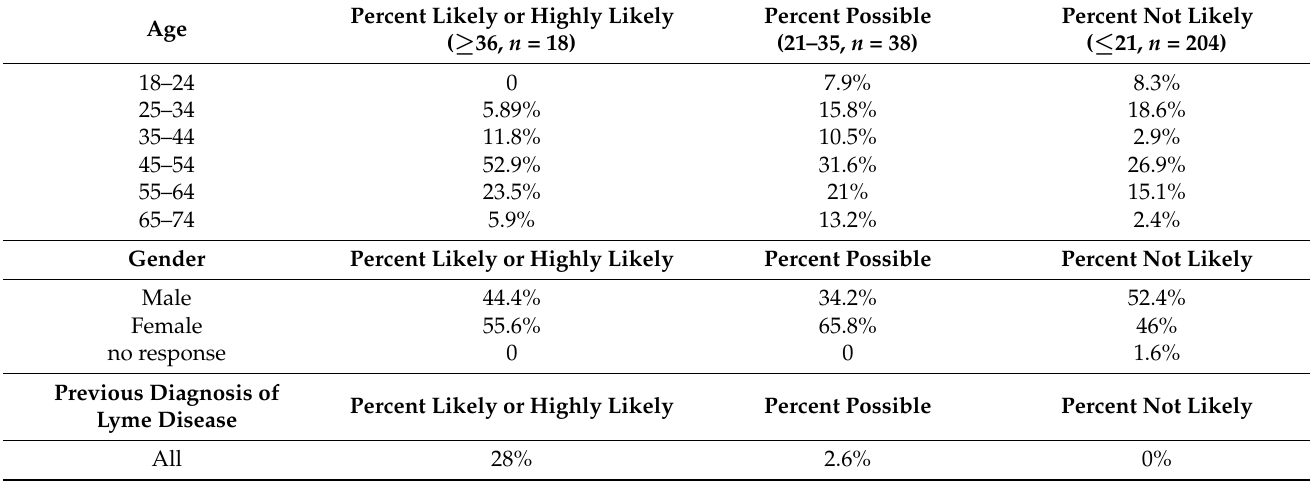
Table 1. In-person survey respondent demographics, N = 260.